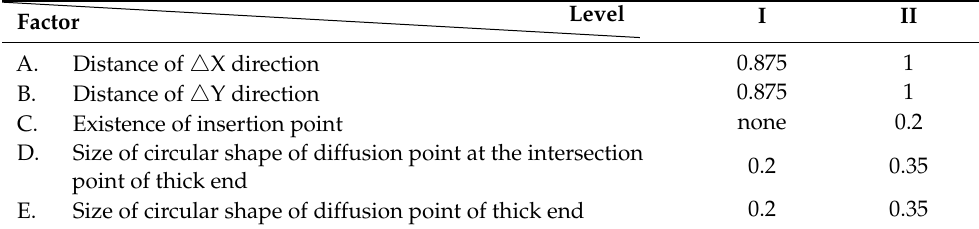
Figure 2. Stagger and insertion pattern of diffusion points of microstructure of light guide plate. Table 1. Values of stagger and insertion pattern of diffusion points of microstructure of light guide plate.